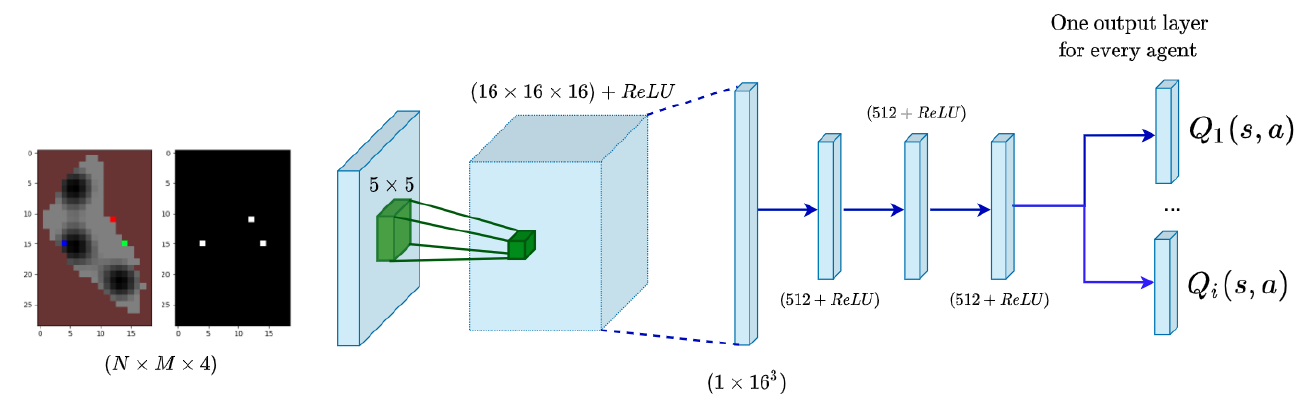
Figure 11. Centralized-learning decoupled-execution network for the multi-agent approach in [25]. Note that the state (left) indicates with vivid colors the different agents positions and an extra channel is added for a better positioning in the collision avoidance